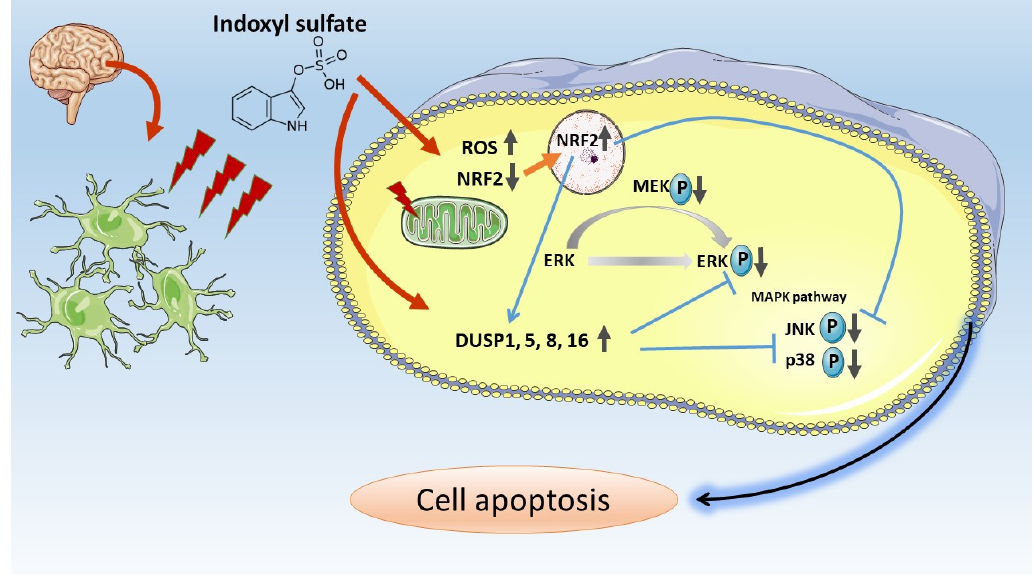
Figure 10. Scheme of proposed IS-induced apoptosis via ROS-NRF2 and MAPK signaling pathways in human astrocytes.